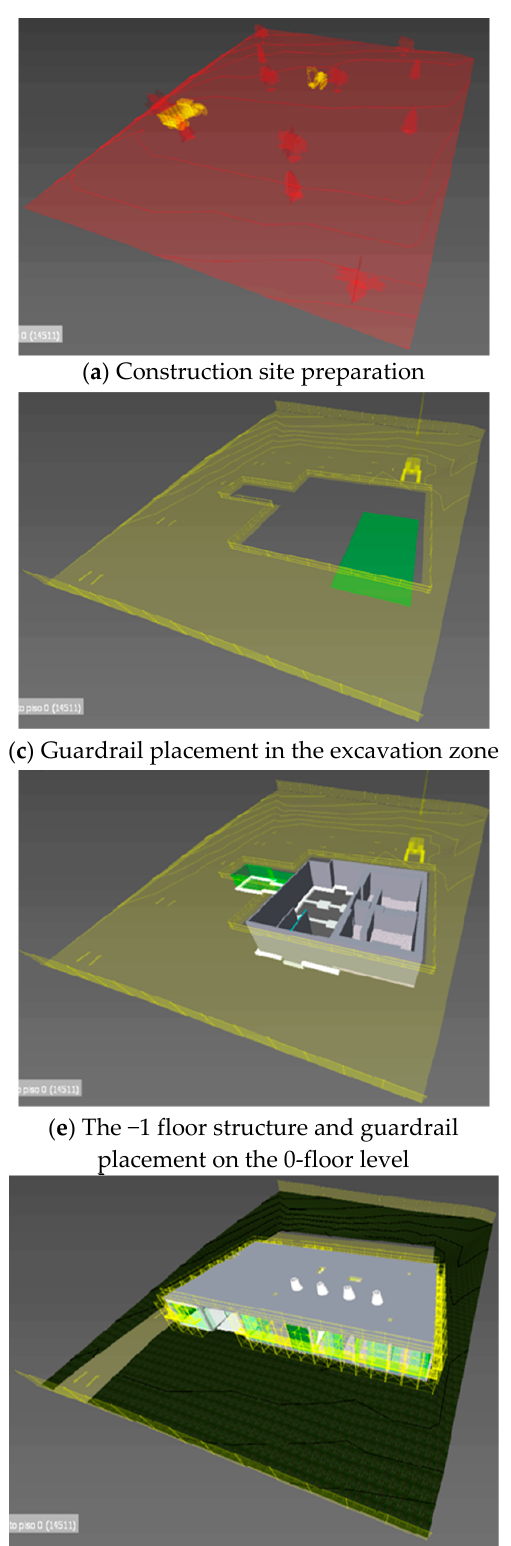
Figure 6. Case study 4D simulation.